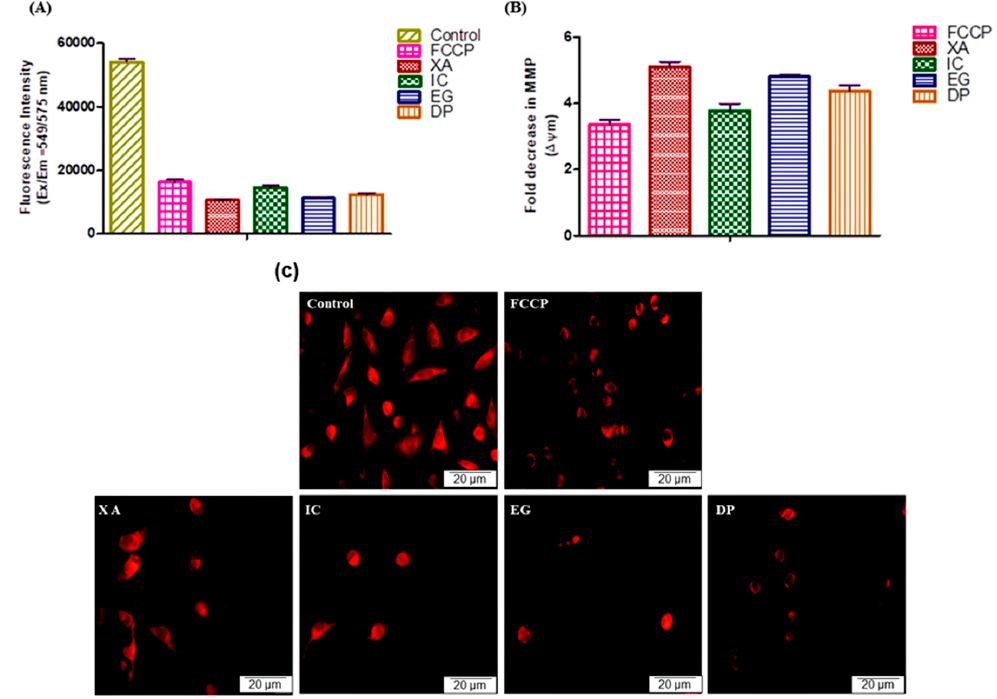
Figure 8. Effect of the IC 50 values of the four plant extracts and 50 µM positive control (FCCP) on the MMP of HeLa cells after 24h. Un-treated cells representing the negative control. ( A ) Fluorescence Intensity after 24 h treatment, ( B ) Analysis of fold Change of MMP. Values expressed in mean ± standard deviation (SD). ( C ) Fluorescence Images after 24 h treatment, visualize the breakdown of MPP after treatment of HeLa cells with the IC 50 of the four studied plant extracts, followed by staining by 500 nM of TMRE.